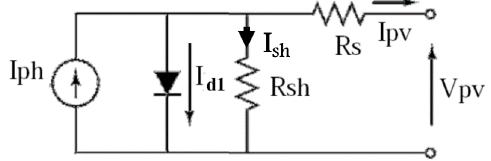
Figure 1 : One diode equivalent circuit of a PV